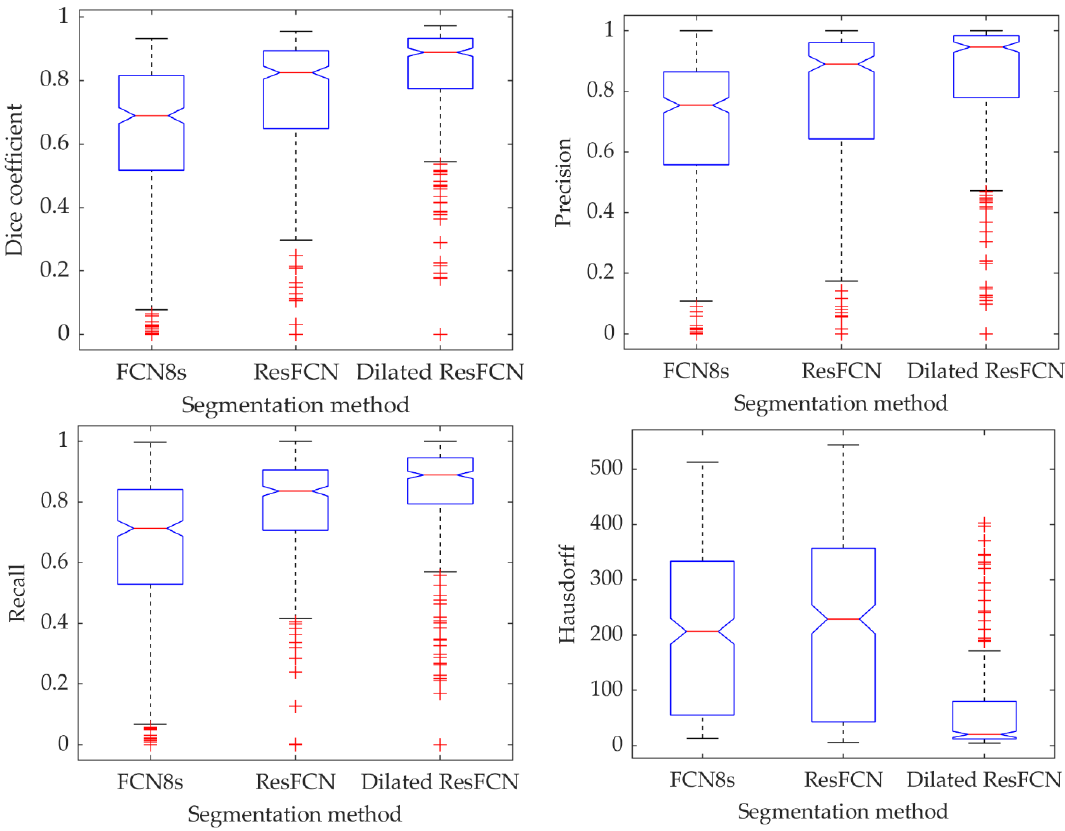
Figure 13. The summative polyp segmentation results for different methods and evaluation measures.